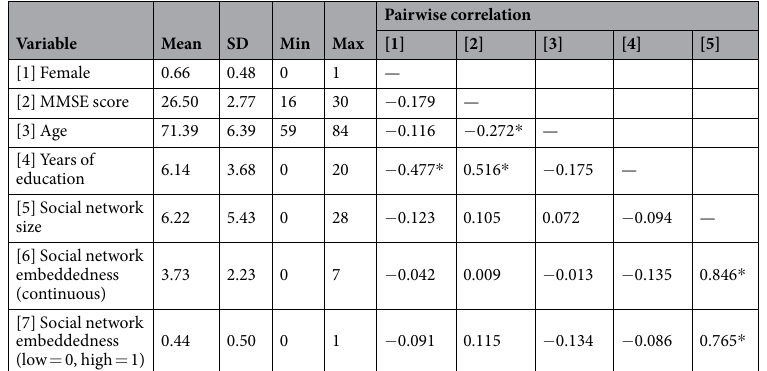
Table 1. Descriptive statistics of the participants (n = 64). Note: * p < 0.05.